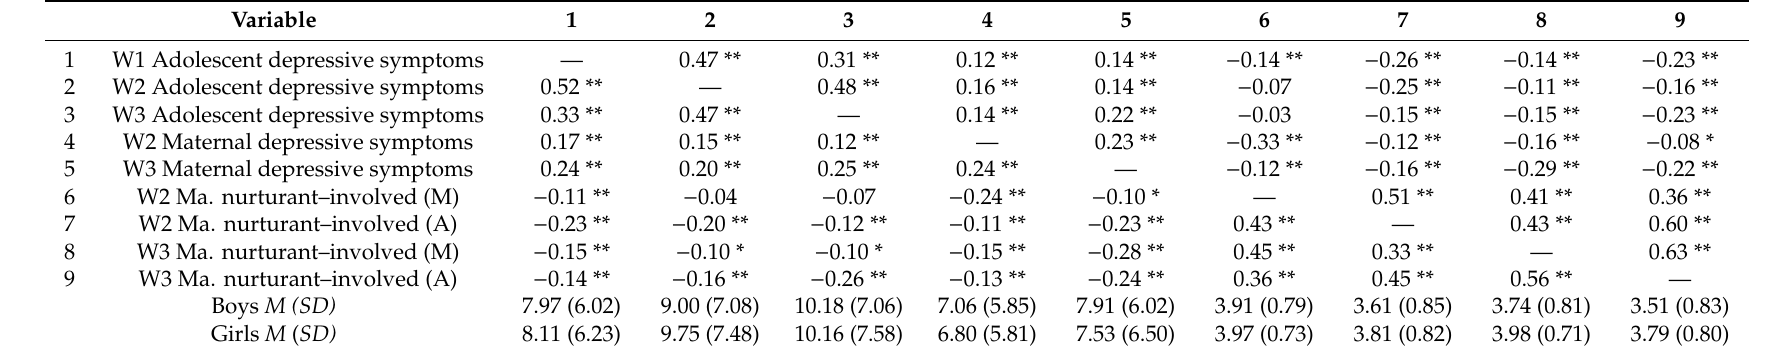
Table 1. Descriptive statistics for the study variables (mother–adolescent) by adolescents’ gender.